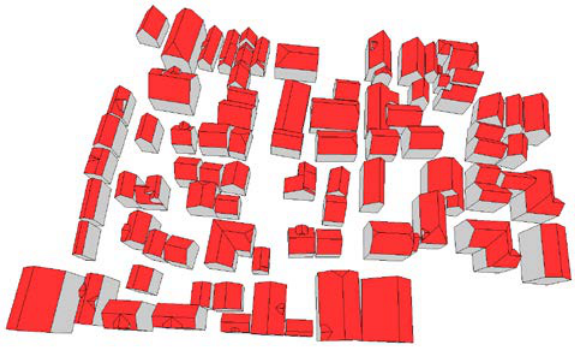
Figure 11. Building models reconstructed in accordance with the rules described in this paper.